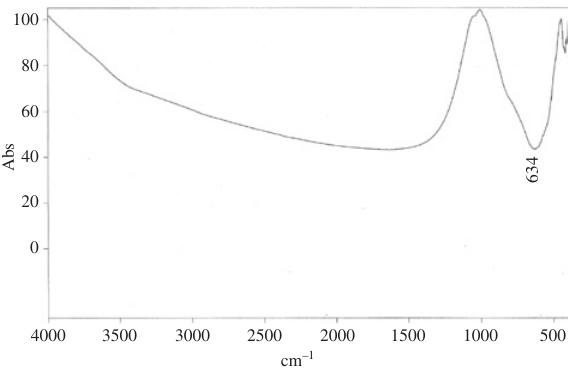
nanoparticles. 2